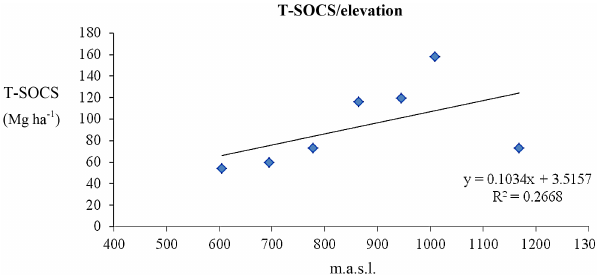
Figure 1. Exponential regression model for T-SOCS versus altitu- dinal gradient. T-SOCS: total soil organic carbon